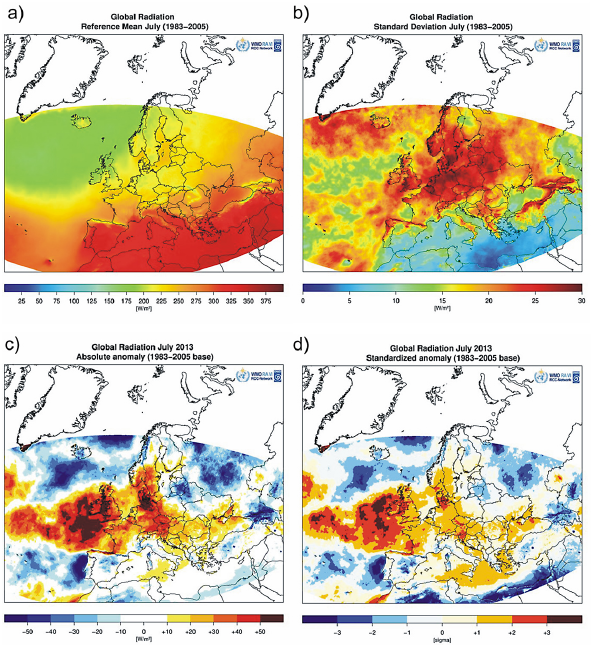
Figure 3. Analysis of global radiation for July 2013 compared to the long-term climate average of 1983–2005 (a) and the standard deviation (b) . Absolute anomalies (c) and standardized anomalies (d) are shown. The upper maps fall into the category of “climate in- formation records” while the bottom maps are “operational climate monitoring” products, which are provided on a monthly